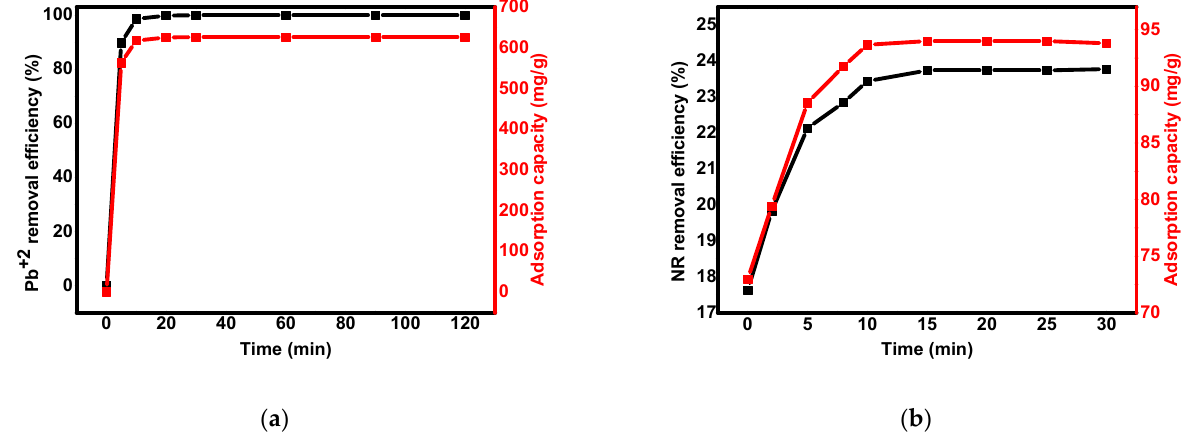
Figure 7. The effect of contact time on Pb 2+ ions ( a ) and NR dye ( b ) adsorption over MnFe 2 O 4 /GO nanocomposite.